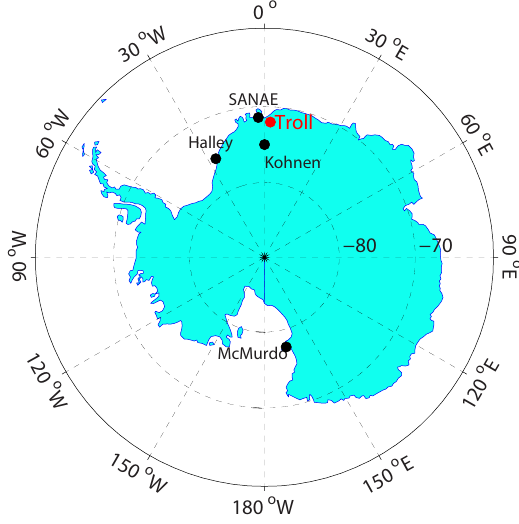
Figure 1. Location of BAS-MRT at the Troll research facility in Antarctica (72 ◦ 01 0 S, 02 ◦ 32 0 E). The instrument’s view direction is 288 ◦ azimuth (toward SANAE), with a zenith angle of 60 ◦